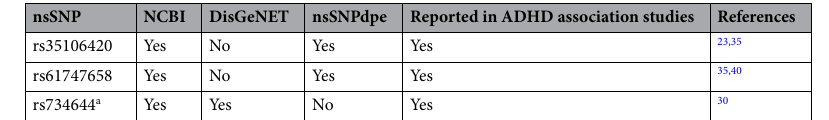
Table 1. ADGRL3 nsSNPs as reported in different databases and ADHD association studies. SNP single nucleotide polymorphism. a According to HaploReg v 4.1 110 , only this marker is synonymous.